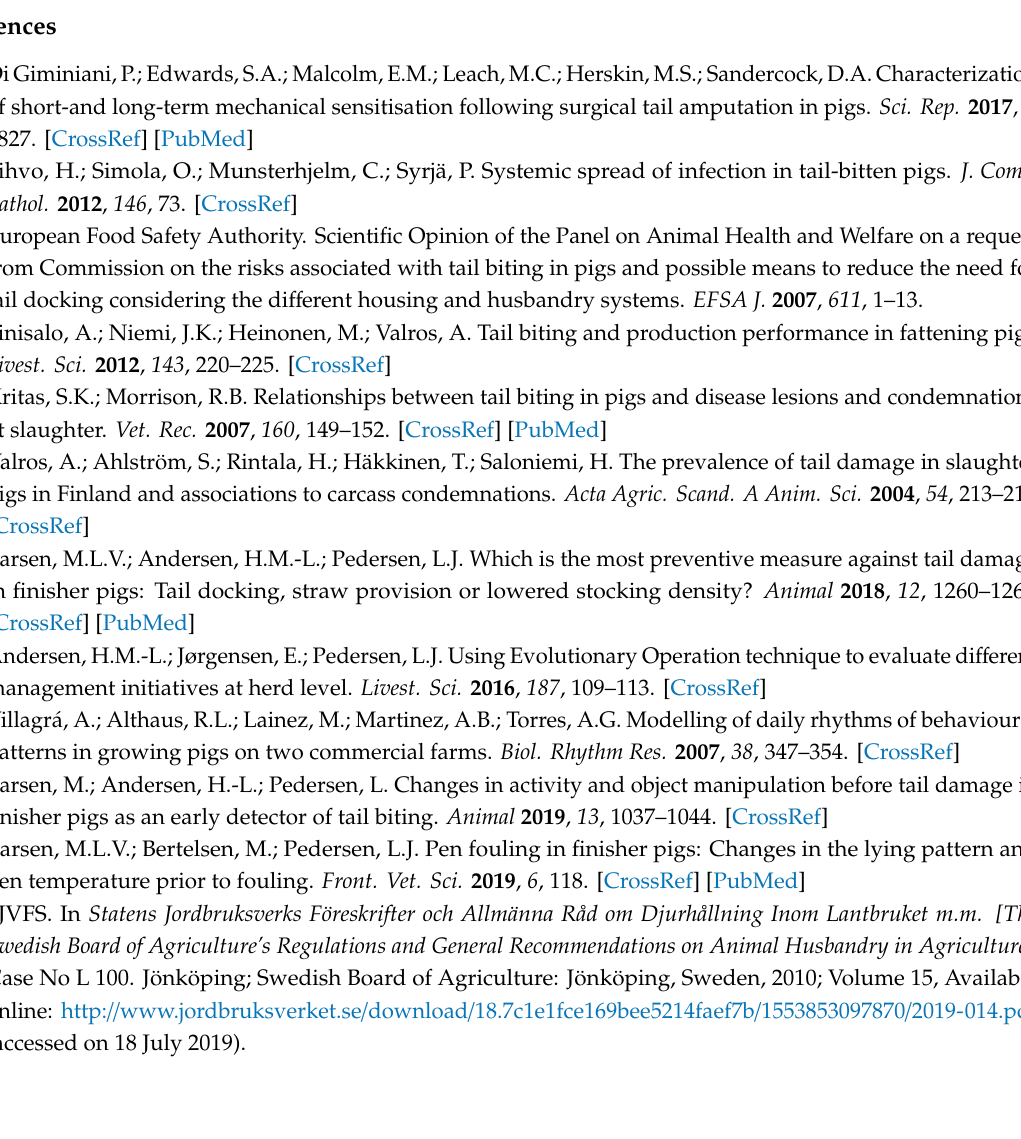
Table S3: ANN optimisation results, Table S4: Predictive performance of FIXED model, Table S5: Predictive performance of alarm type UNTIMED; Table S6: Predictive performance of alarm type BEFORE, Table S7: Predictive performance of alarm type